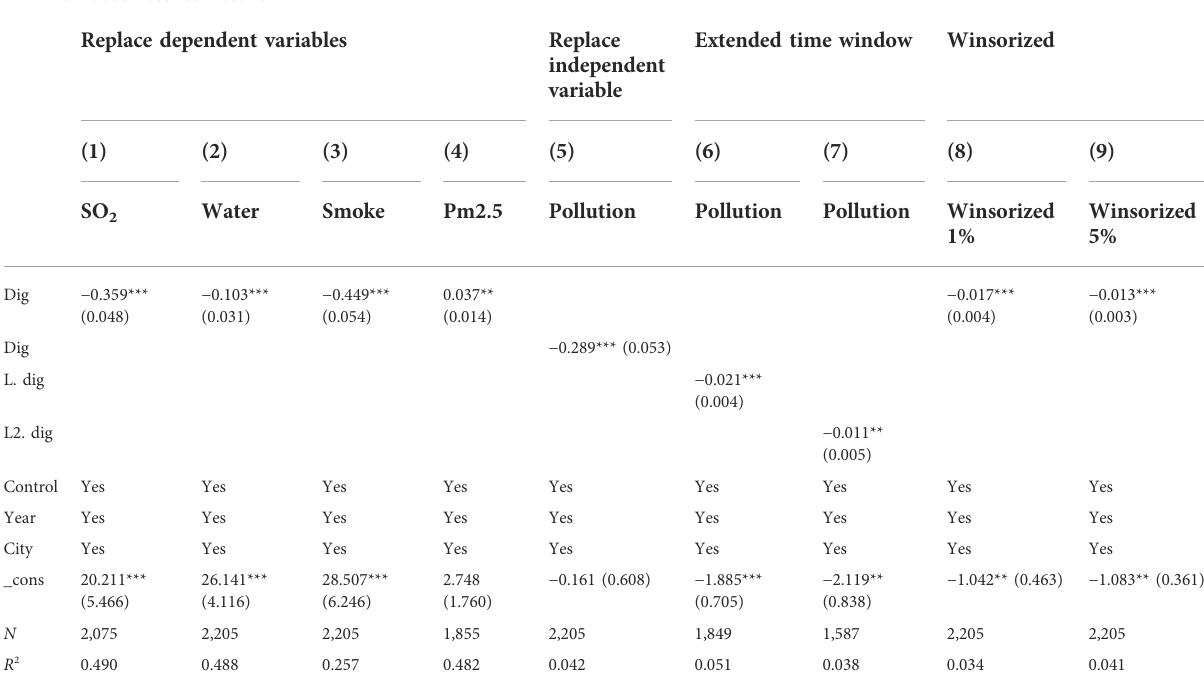
TABLE 8 Robustness test